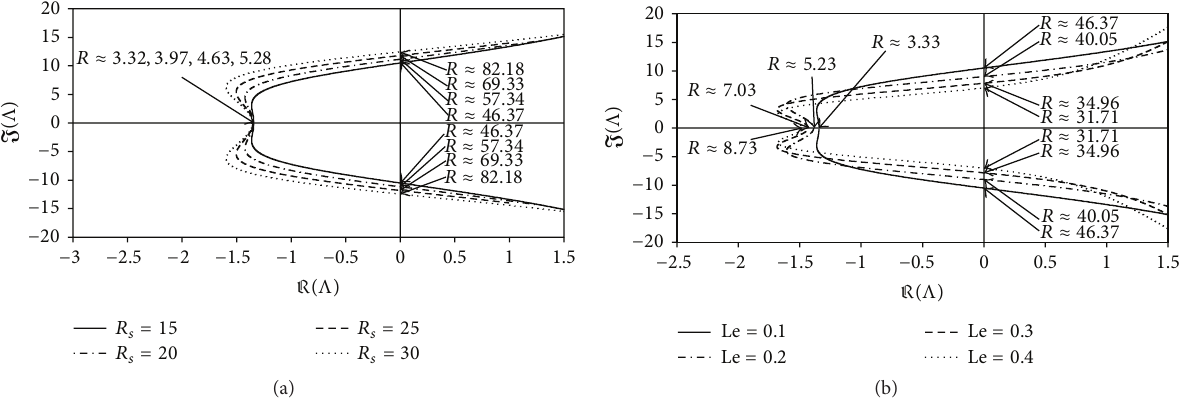
Figure 3: The evolution of the complex eigenvalues with increasing Rayleigh number for Pr = 10 , 𝜆 = 8/3 , (a) Le = 0.1 , and (b) 𝑅 𝑠 = 15